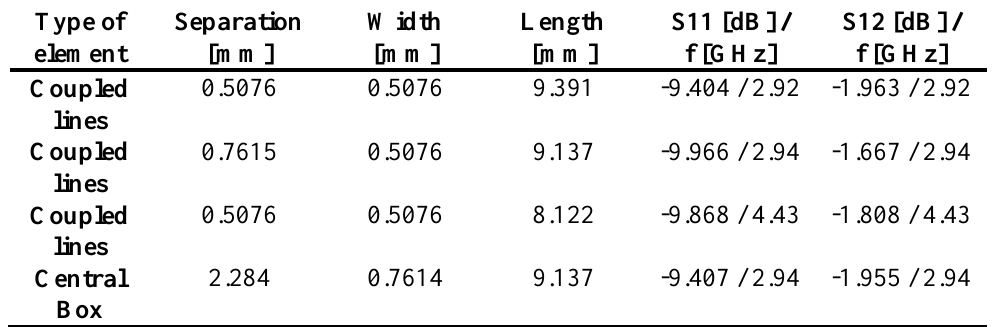
Table 1. Parametric